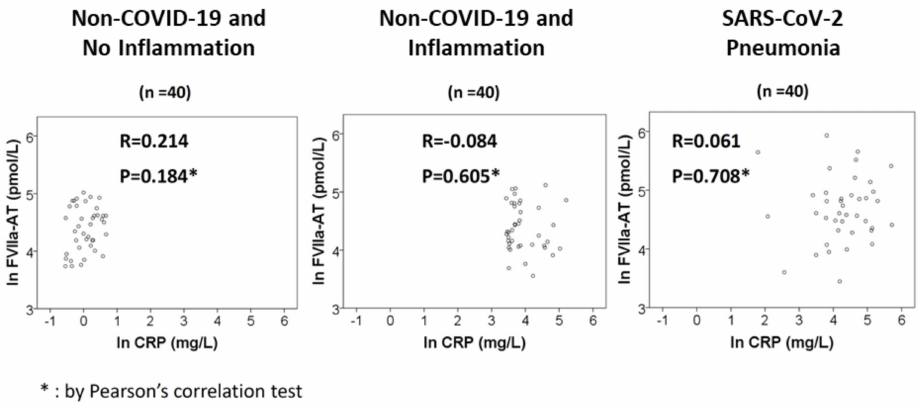
Figure 4. FVIIa-AT–CRP correlation. Correlations between activated factor VII–antithrombin complex (FVIIa-AT) and C-reactive protein (CRP) plasma levels in the three study groups. In subsample analysis (information on FII:c, FV:c, and FVIII:c was available only in a limited number of non-COVID-19 subjects), FII:c, FV:c, and FVIII:c were lower in subjects with SARS-CoV-2 pneumonia, with the highest FVIII:c levels in subjects without COVID-19 and with inflammation (Table 1).